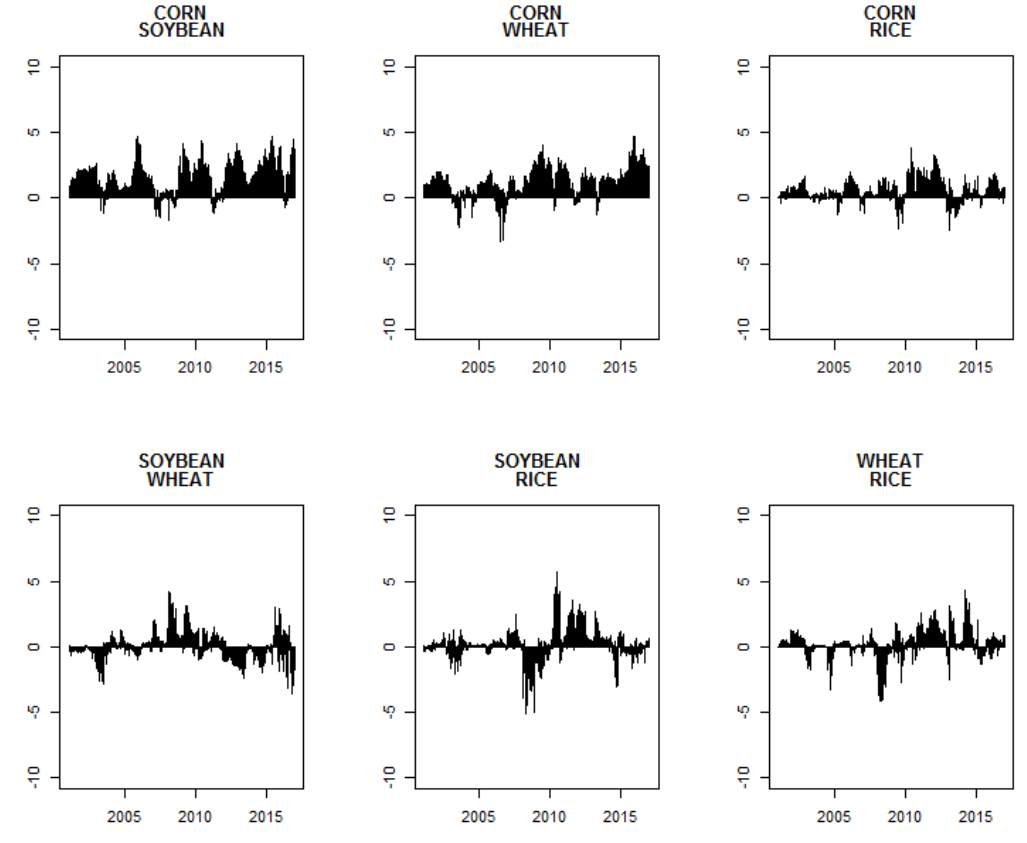
Figure 7: Pairwise net volatility spillovers within the food markets (the lasso